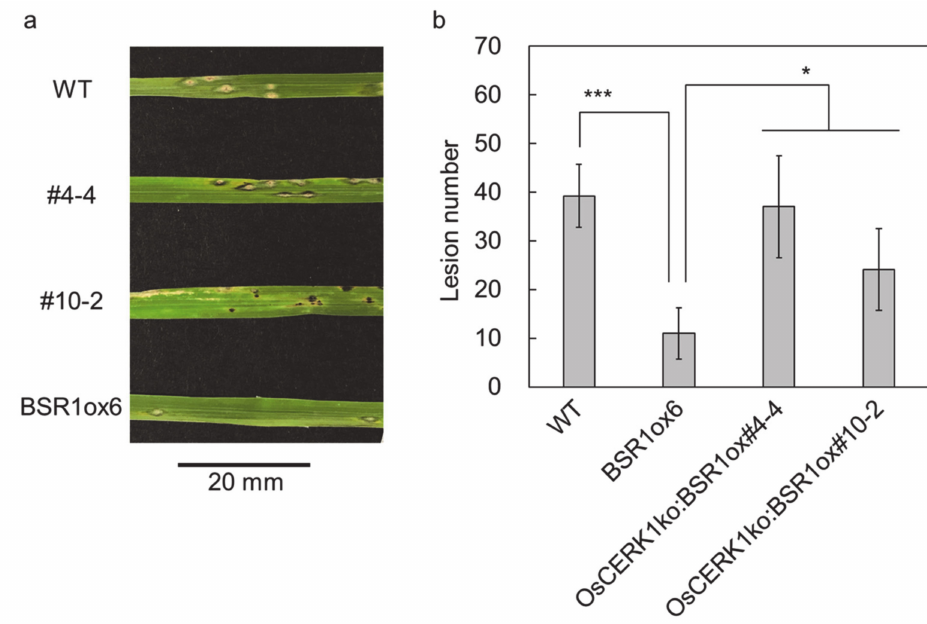
Figure 3. Knockout of OsCERK1 impairs BSR1 overexpression-mediated enhancement of rice blast resistance. ( a ) A photograph of the 4th leaf blades. ( b ) The number of compatible lesions on the 4th leaf blade counted on day 6 after inoculation. Pyricularia oryzae was spray-inoculated onto plants at the 3.5–4.0 leaf stage. Values are presented as the means ± standard deviations ( n = 8, 8, 8, and 10 for WT, BSR1 ox6, OsCERK1 ko: BSR1 ox#4-4, and OsCERK1 ko: BSR1 ox#10-2, respectively). Experiments were conducted twice, with similar results. * p < 0.05, Dunnett’s test for OsCERK1 ko: BSR1 ox#4-4 and OsCERK1 ko: BSR1 ox#10-2 vs. BSR1 ox6; *** p < 0.001, t -test, WT vs. BSR1 ox6. WT, wild-type; ox, overexpression; ko,